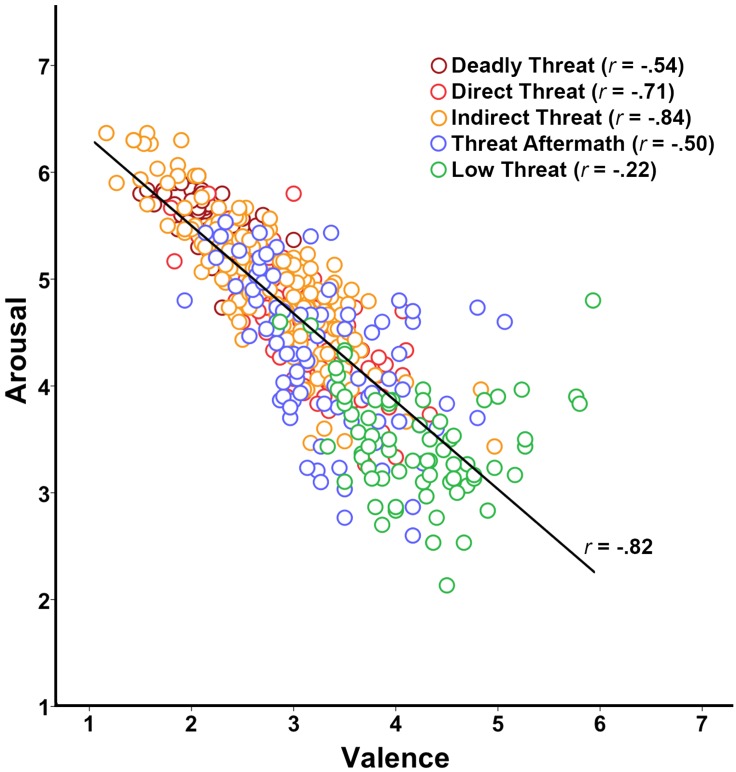
Study 2 results. The relationship between valence and arousal ratings, with valence (measured on a 1–7 Likert scale) on the x-axis and arousal (also measured on a 1–7 Likert scale) on the y-axis. The colors correspond to image categories.